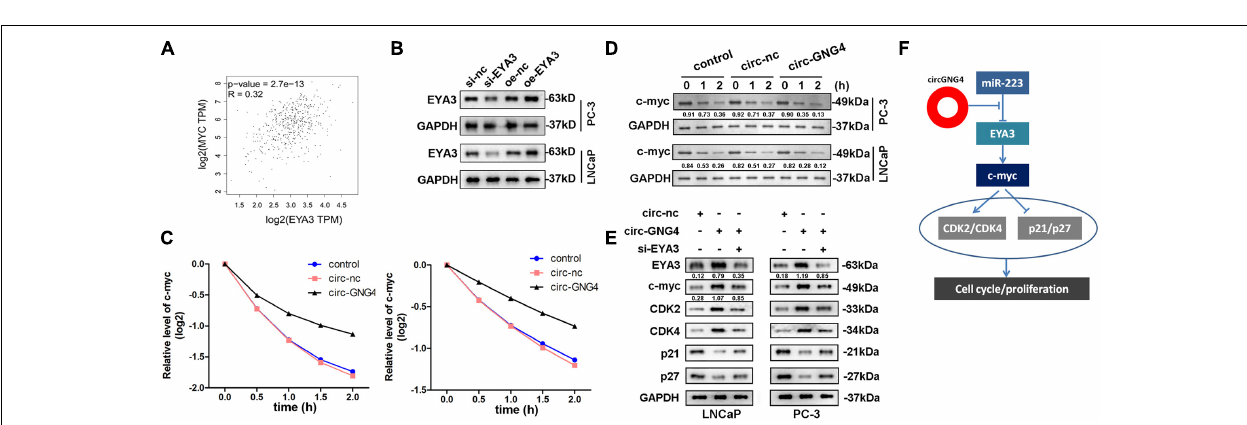
FIGURE 7 | CircGNG4/miR-223/EYA3/c-myc axis mechanism. (A) GEPIA (http://gepia.cancer-pku.cn/) database was used to find the related gene of EYA3. (B) Western blot was used to detect the expression of c-myc after EYA3 knockdown or overexpression. (C) The half-life of c-myc mRNA was detected by